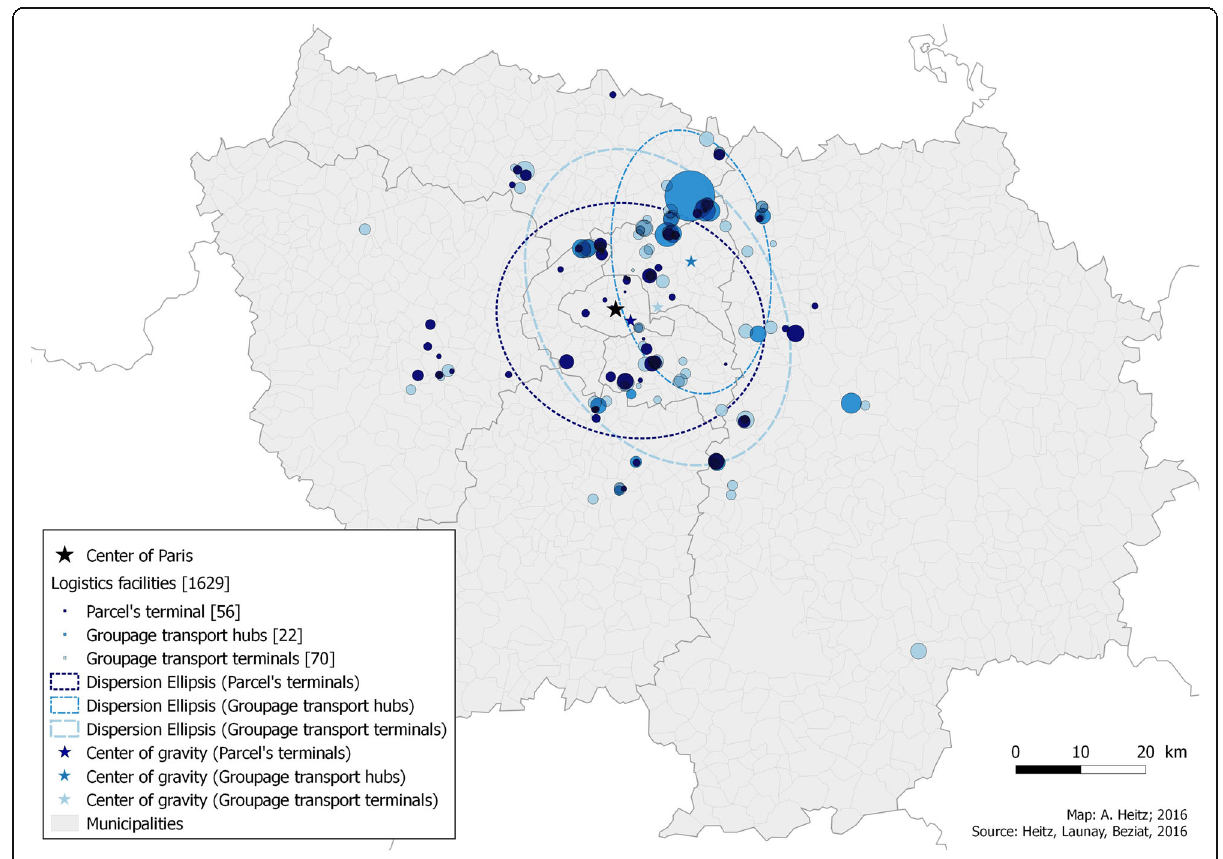
Fig. 3 Spatial distribution of groupage network hubs and